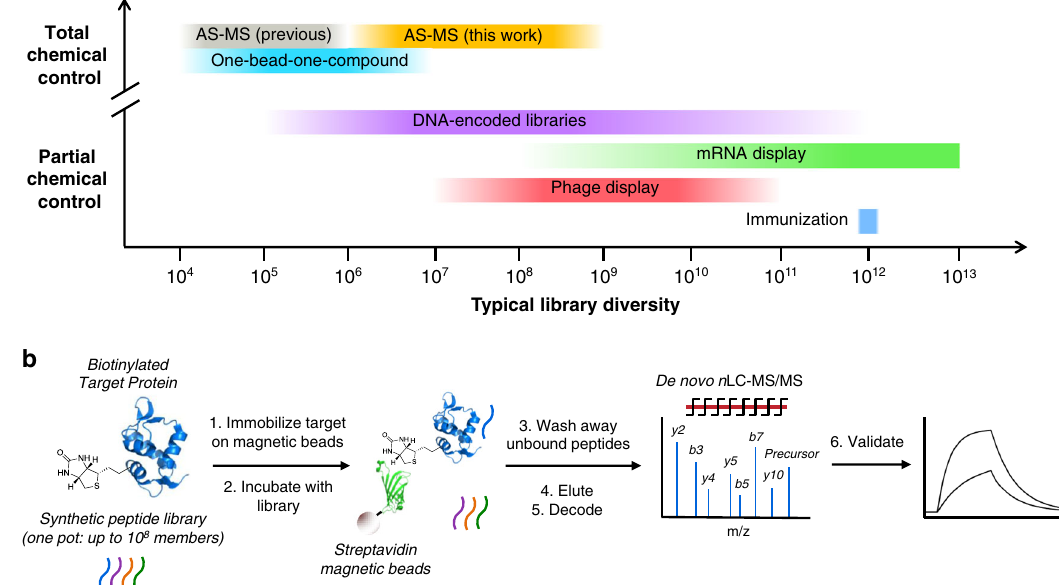
Fig. 1 AS-MS enables discovery from randomized, high-diversity chemical libraries. a Among existing techniques for peptide binder discovery, increased chemical control over library synthesis and screening typically comes at the cost of limited library diversity. Af fi nity selection-mass spectrometry (AS-MS; this work), which relies on chemically accessed libraries and direct identi fi cation of active members, can investigate library diversities on the order of 10 8 – 10 9 while maintaining a high degree of chemical control over the synthesis and selection process. b A typical AS-MS work fl ow, which uses magnetic beads as a partitioning reagent to discriminate bound from unbound library members, and nano-liquid chromatography-tandem mass spectrometry to identify sequences of active